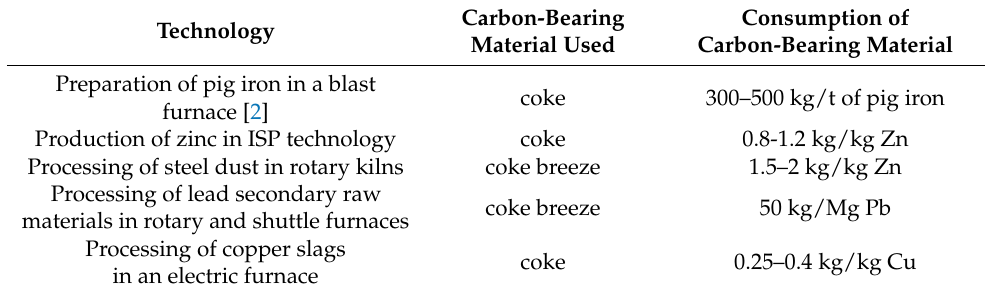
Table 1. The amount of coke and coke breeze consumed in pyrometallurgical